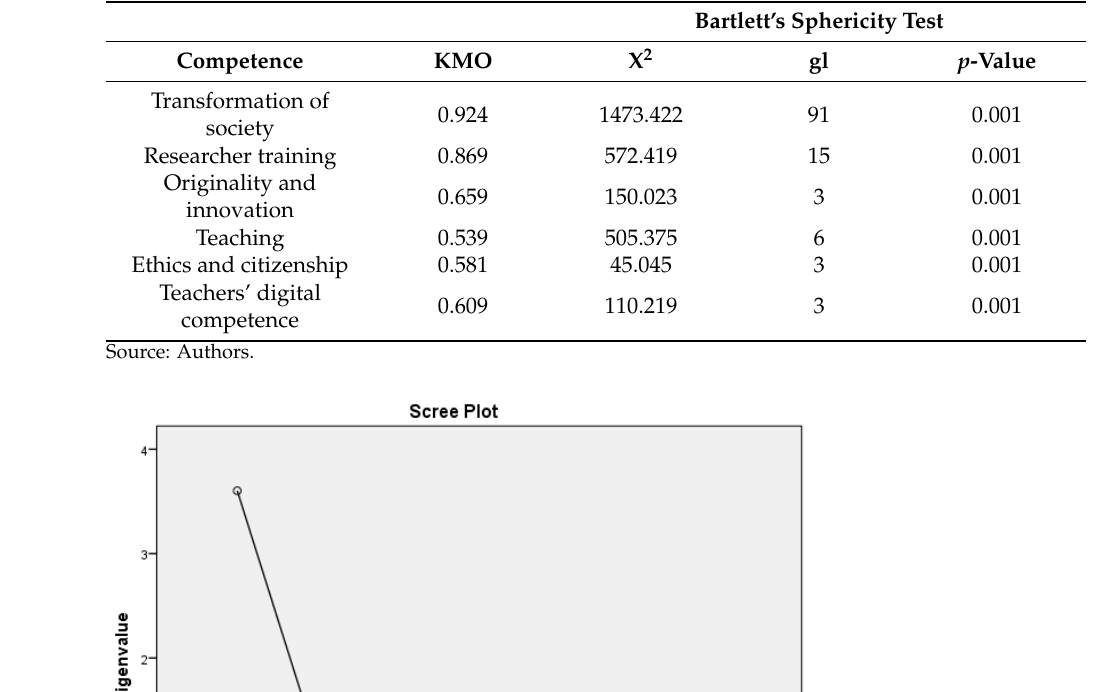
Table 5. KMO Sample Adequacy Measures and Bartlett’s Sphericity Tests.